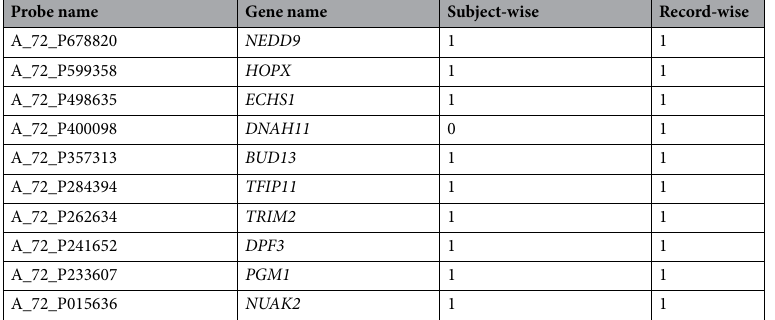
Table 2. The most accurate gene-based classifiers for survival prediction. Subject-wise most accurate classifier comprised of nine probes and the most accurate record-based classifier comprised of ten probes. As evident, nine of the ten genes were common between the two methods “0” stands for absence and “1” stands for presence in the